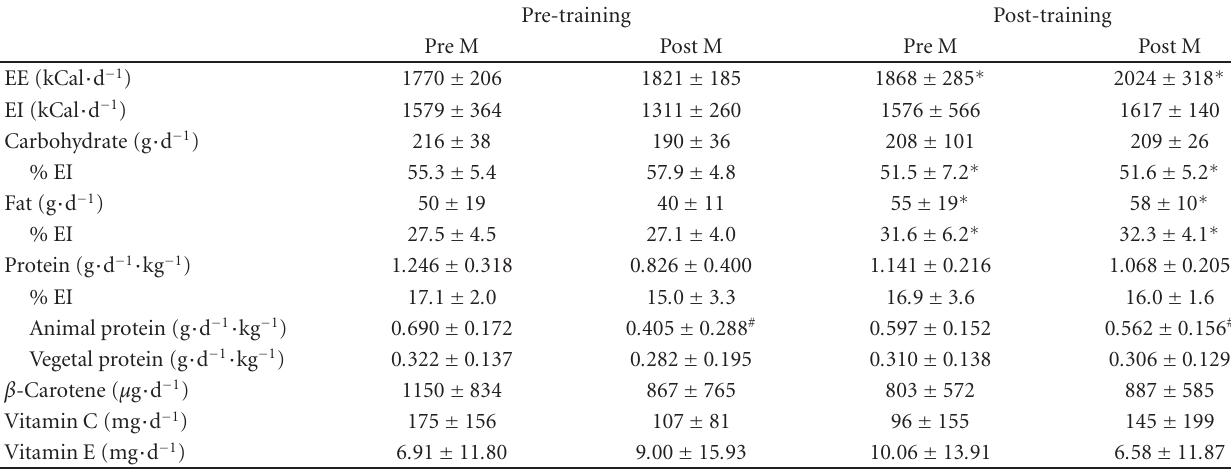
Table 2: Daily energy expenditure and daily nutrient intake of pre- and post-menopausal women before and after the Tai Chi training period.